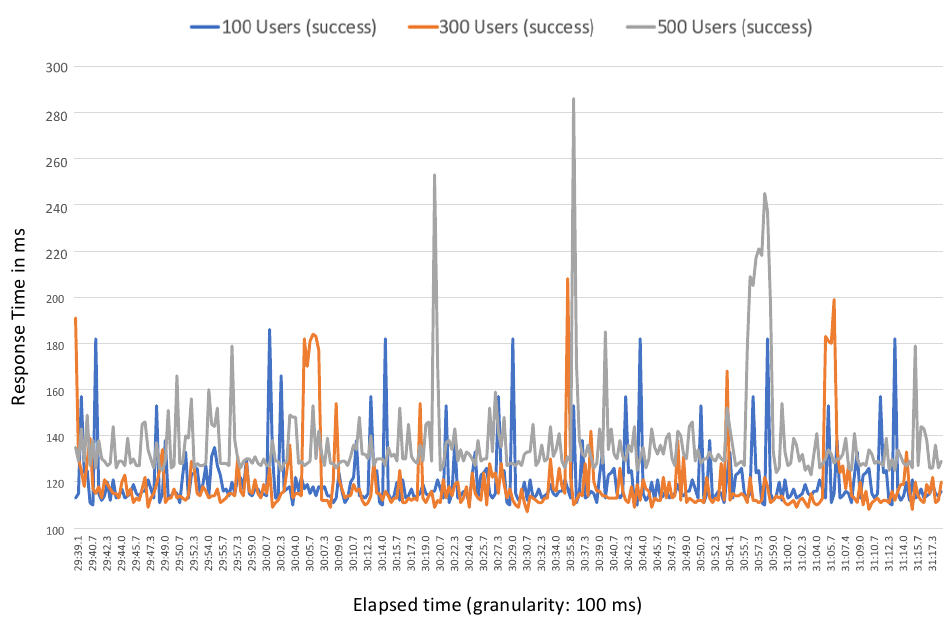
Figure 26. Response time for different simultaneous